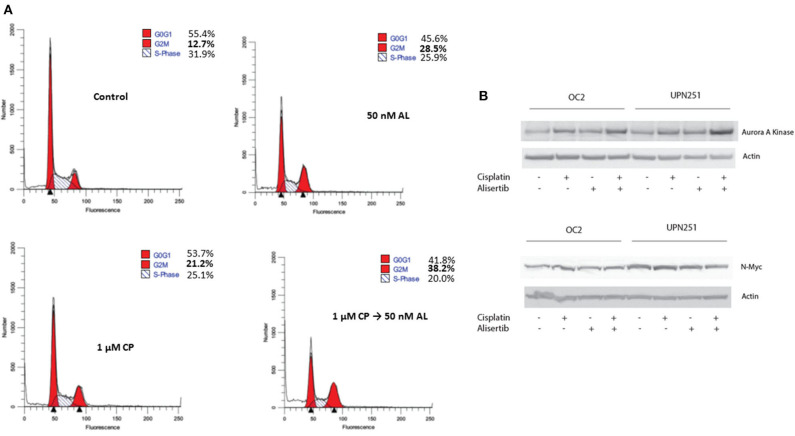
Alisertib enhances accumulation of cells in G2/M following cisplatin treatment. (A) UPN251 cells were treated with cisplatin (CP), for 3 h followed by 50 nM alisertib for 48 h. Following treatment cells were stained with and propidium iodide and analyzed by flow cytometry. (B) OC2 and UPN251 cells were treated as in Figure 2A and cell lysates prepared following drug treatment. Lysates were analyzed by SDS-PAGE and probed for expression of AAK, N-myc, and actin.